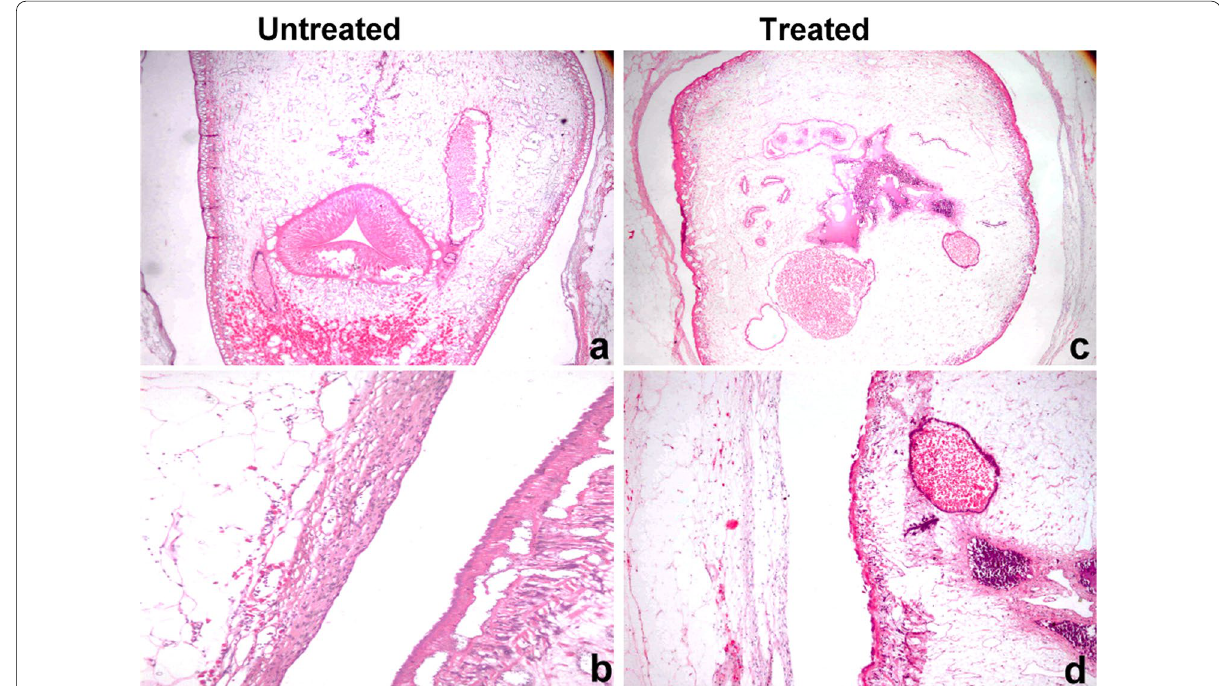
Fig. 6 a–c Histological section of clinostomum spp. In untreated control group showing normal intact internal structures. d – f In treated control group showing degeneration and edema of the internal structures of